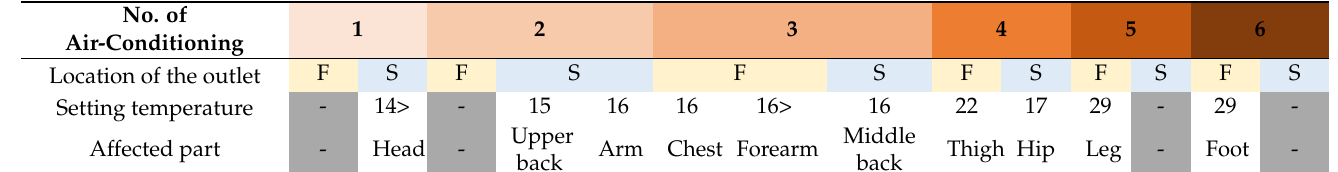
Table 2. Optimum setting temperature for personal air-conditioning system and body parts affected by each air conditioning. (F: front seat depicted as yellow-colored cells, S: target seat depicted as bule-colored